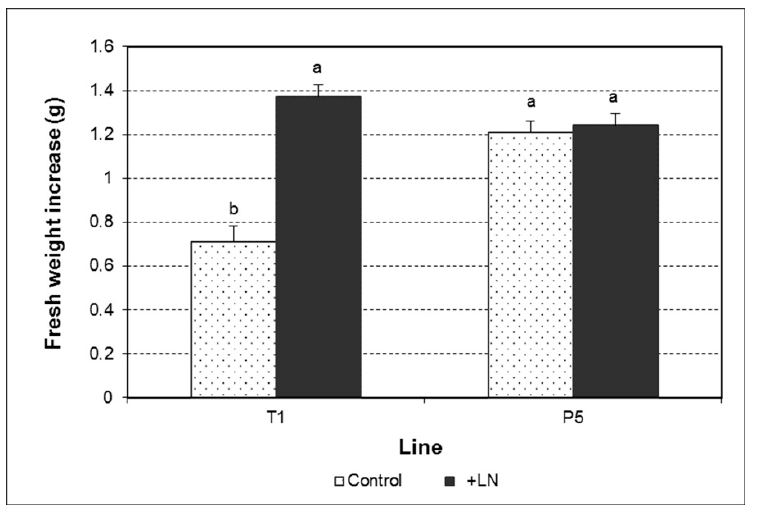
Figure 2. Fresh weight increase of olive embryogenic cultures control and derived from cryo- preserved somatic embryos of the lines T1 and P5. Data assessed six weeks after the last subcul- ture. Data represent the mean ± SEM. Different letters indicate significant differences by the least significant difference (LSD) test with a significance level of 0.05.